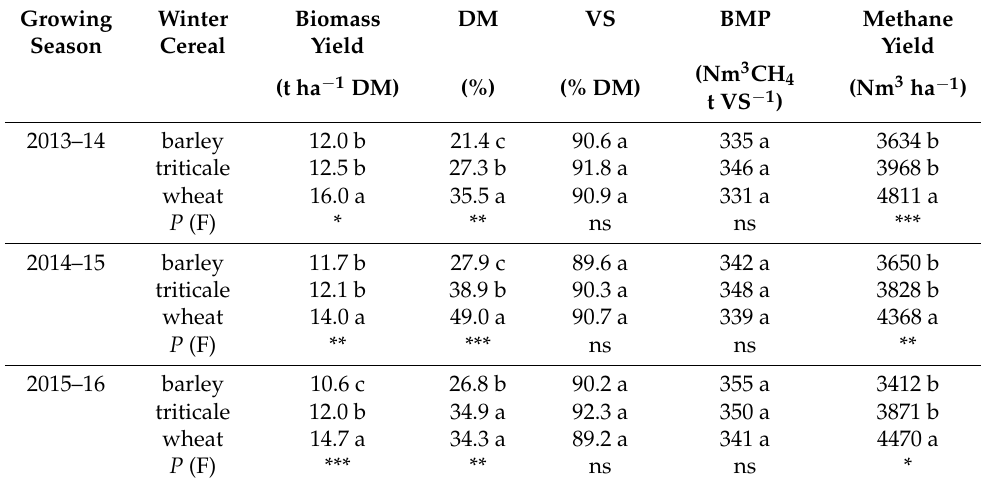
Table 4. Biomass yield, biochemical methane potential (BMP) and methane yield per hectare of the considered winter cereals 1 .